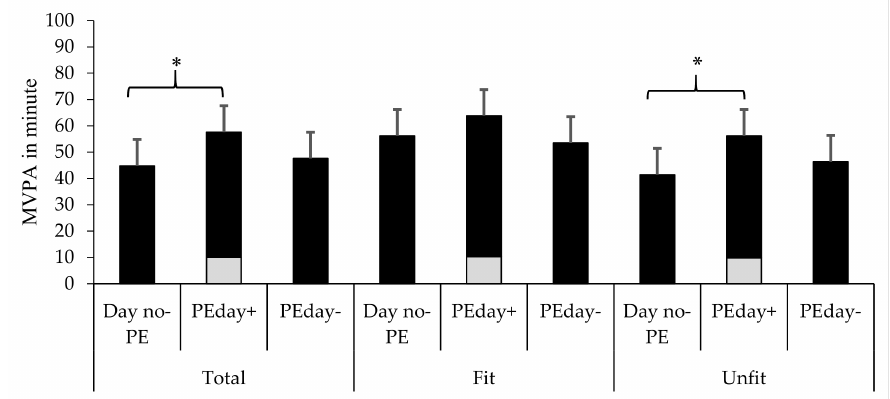
Figure 2. Adjusted time spent on MVPA on Day no-PE, PEday + , and PEday − , by the total sample, and fit and unfit schoolchildren. Gray squares refer to MVPA in PE. *Significant di ff erences between groups.